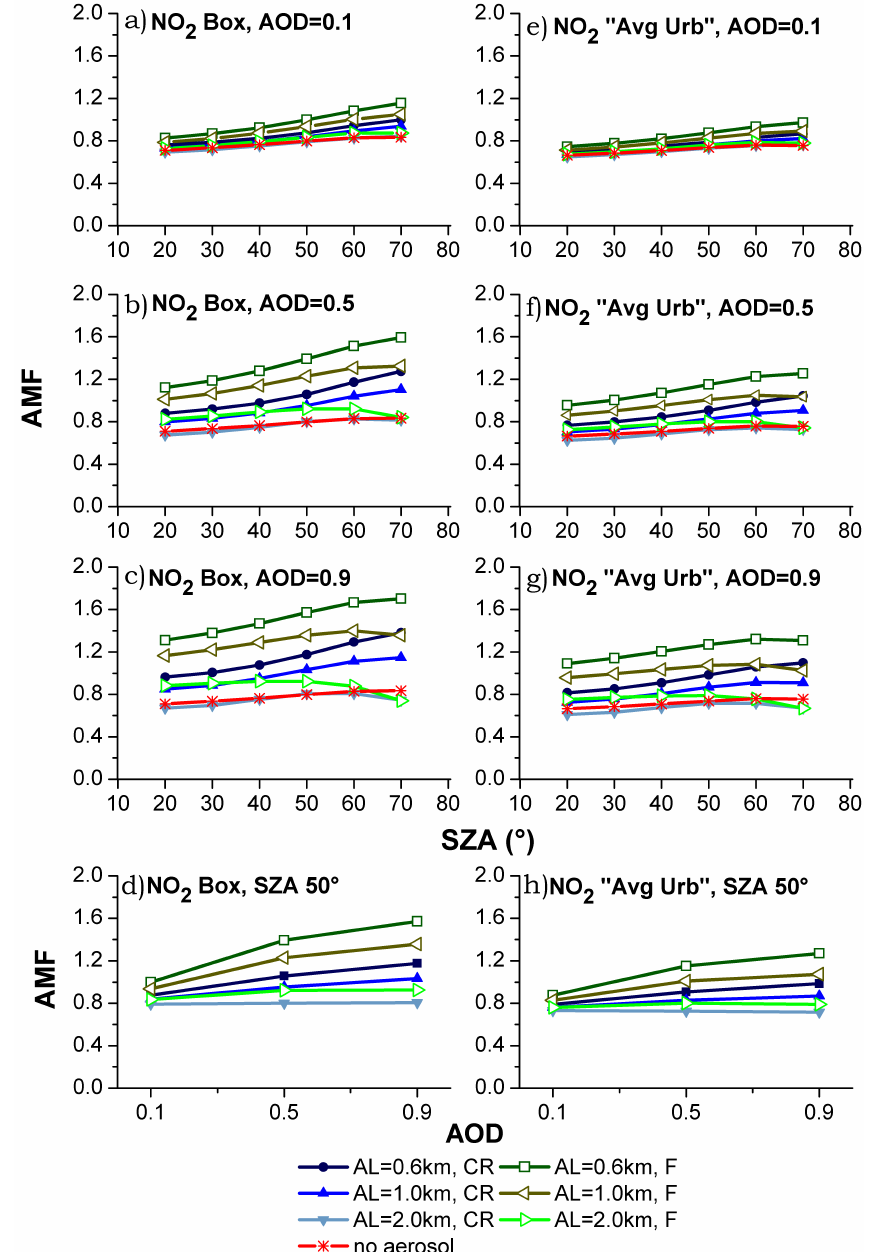
Fig. 7. (a) – (c) NO 2 airmass factors for a 1.0km box NO 2 profile using no aerosol (red) and for the scenarios B, C and F (extension of aerosol layer (AL) from surface to 0.6, 1.0 and 2.0km, respectively) calculated with the phase functions determined for coarse (CR) and fine (F) particles (optical properties taken from Creteil/Paris AERONET station). AMFs determined at 440nm, with surface albedo = 0.03, ω 0 = 0.93 and different AODs: 0.1, 0.5 and 0.9. (e) – (g) Same as (a)–(c) for the aerosol settings but using the average of modelled urban NO 2 profile (“Avg Urb”). AMFs results in panel (d) and (h) are presented for SZA = 50 ◦